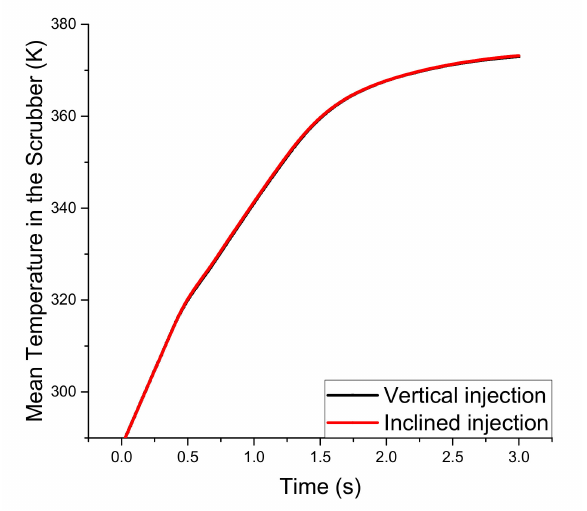
Figure 19. Average temperature inside the